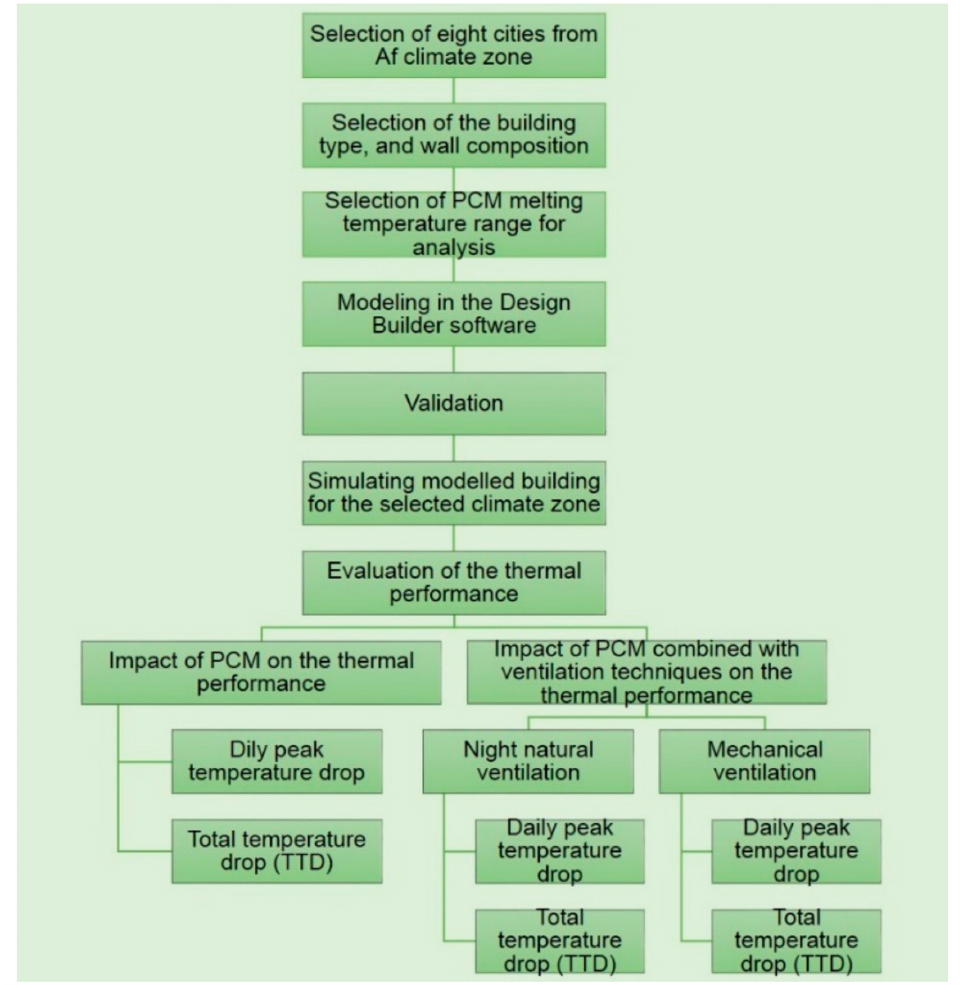
Figure 1. Methodology of the